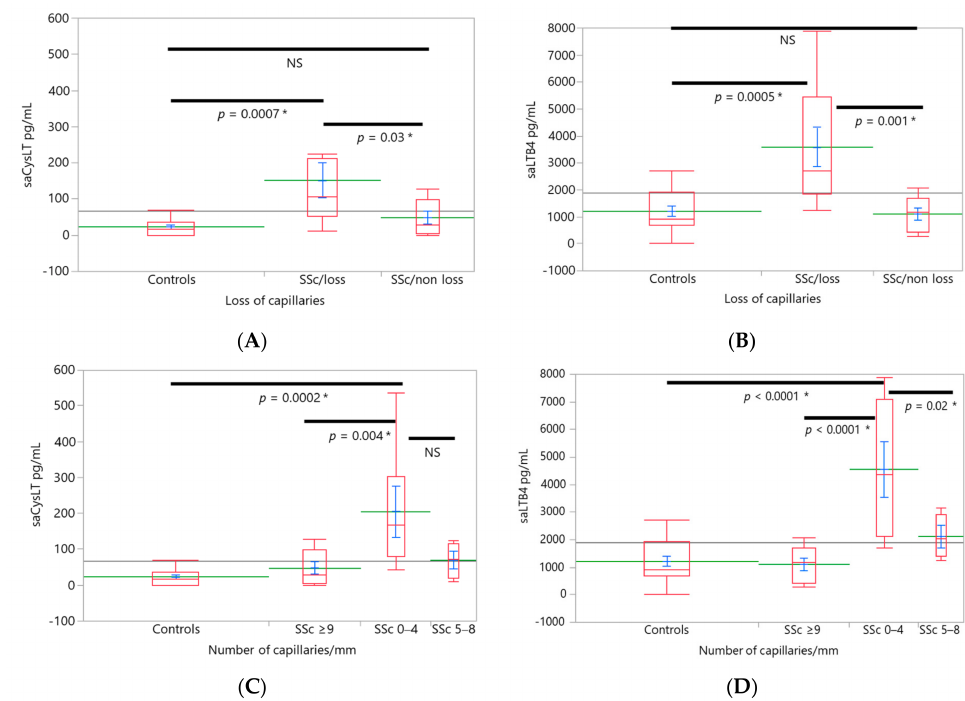
Figure 3. LT levels and NFC findings. Levels of leukotrienes were associated with abnormal nailfold capillaroscopy. Box plots (red), mean (green), mean error bars (blue) and grand mean (grey line across the boxes) are shown. Overlap marks are drawn to illustrate statistical differences between the groups. The X axis is proportional. Levels of salivary CysLT ( A ) and LTB4 ( B ) were higher in the SSc group with capillary loss compared to SSc group without loss and controls (capillary number ≥ 9 capillaries per millimeter). Levels of salivary CysLT ( C ) and LTB4 ( D ) were higher in the group with a number of capillaries between 0–4 per millimeter compared to the group with SSc with a normal number of capillaries ( ≥ 9 capillaries/millimeter) and control group. In addition, salivary LTB4 were higher compared to SSc group with 5–8 capillaries/mm. Analysis of covariance (ANCOVA) was used for analysis and Tukey HSD test was used to detect the differences between all pairs. SSc: systemic sclerosis, LTs: leukotrienes, saCysLT: salivary cysteinyl-leukotrienes, saLTB4: